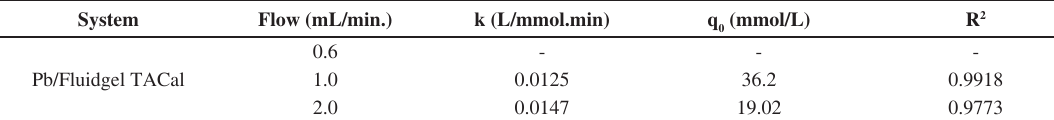
Table 2. Fitting parameters of the Adams-Bohart model to study flow.